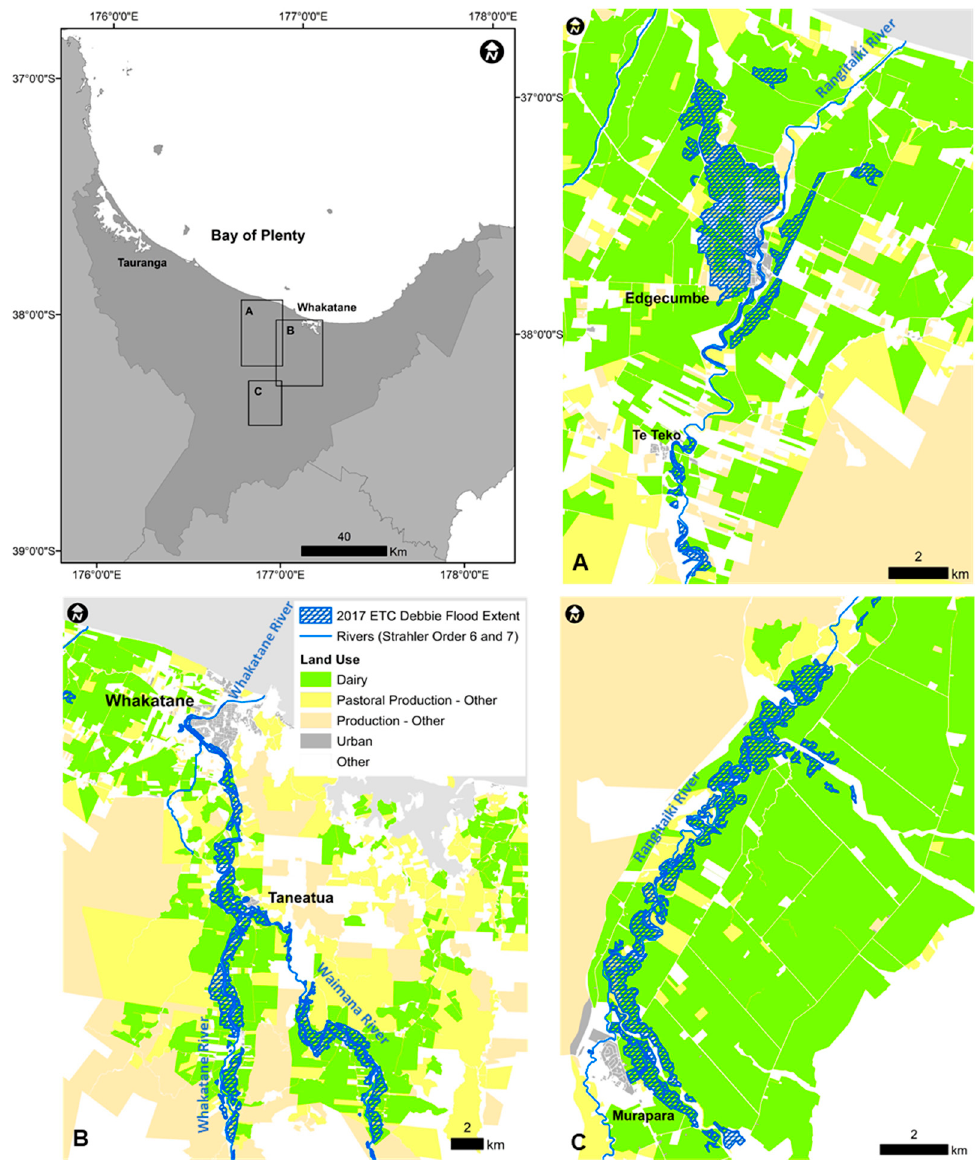
Figure 1. Study area map including approximate flood extents identified from satellite images and dairy farmland use coverage. Case study farms are not identified to preserve the privacy of farm ‐ ers.